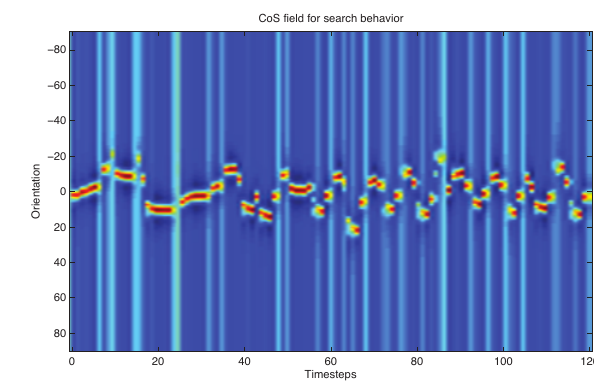
Figure 9. Activity of the CoS field for the Search behavior when the Approach behavior is explored